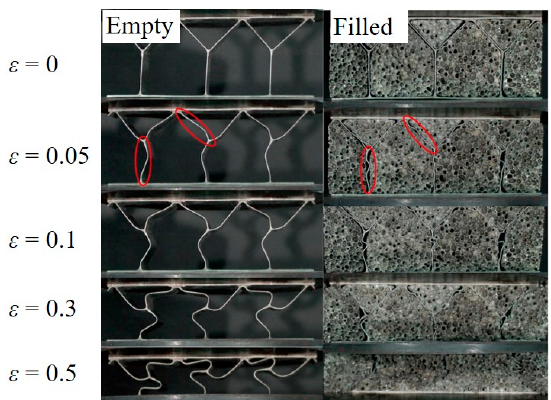
Figure 7. Images of both empty and aluminum foam-filled Y-shape cored sandwich panels under different compressive strain illustrating the deformation history, t = 0.41 mm.